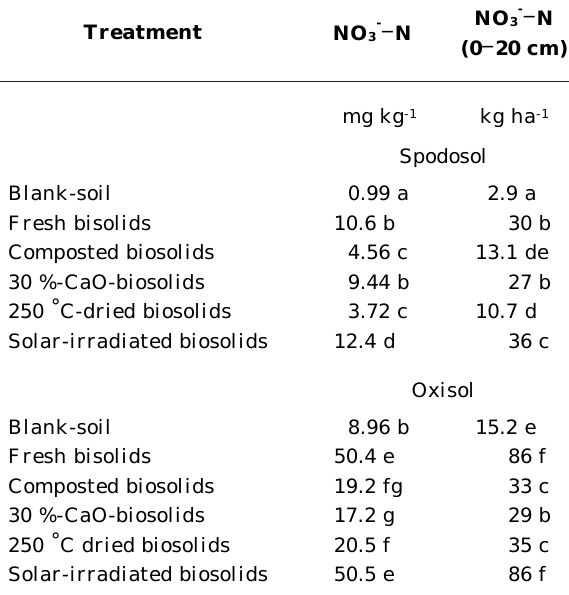
Means with same letter within rows are not statistically different by the Tukey